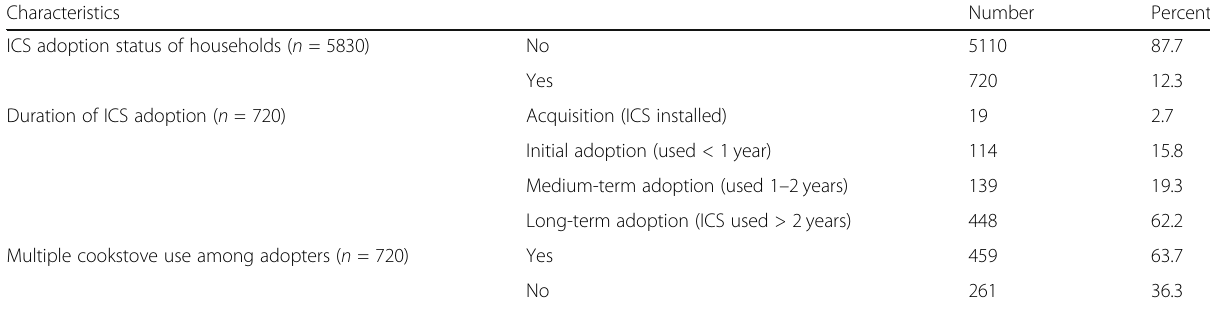
Table 2 Improved cookstove adoption status of study households in Northwest Ethiopia, 2018